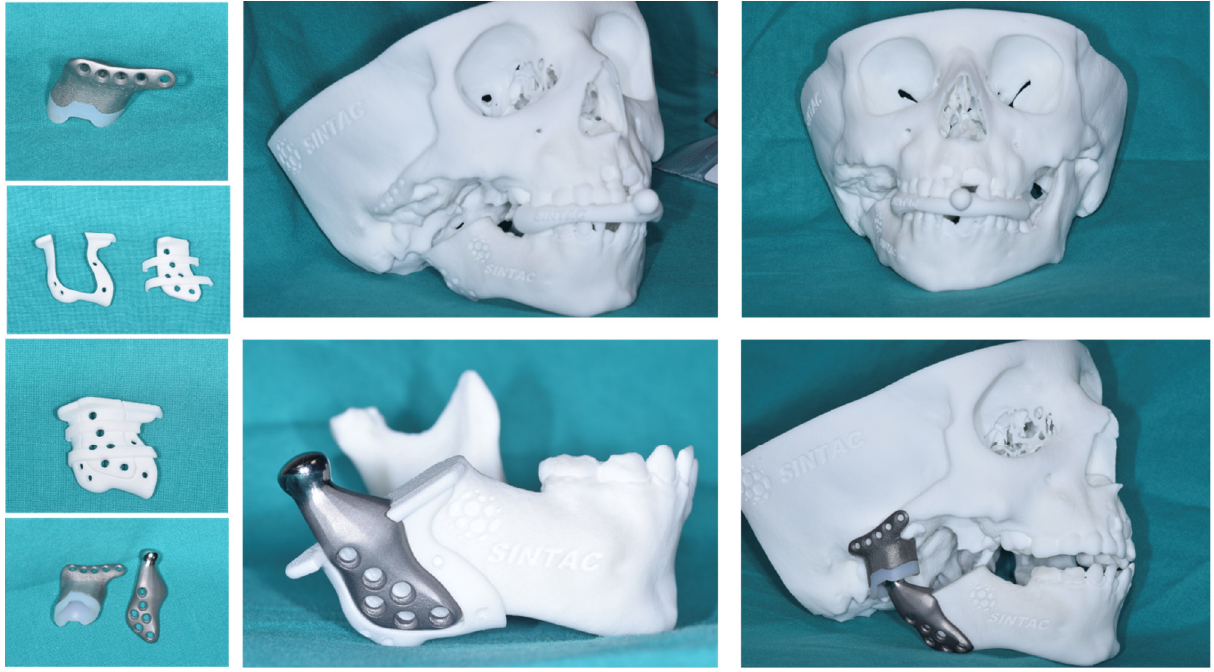
Figure 6. Fitting test of the custom-made prosthesis on the 3D printed model of the patient’s cra- nium.